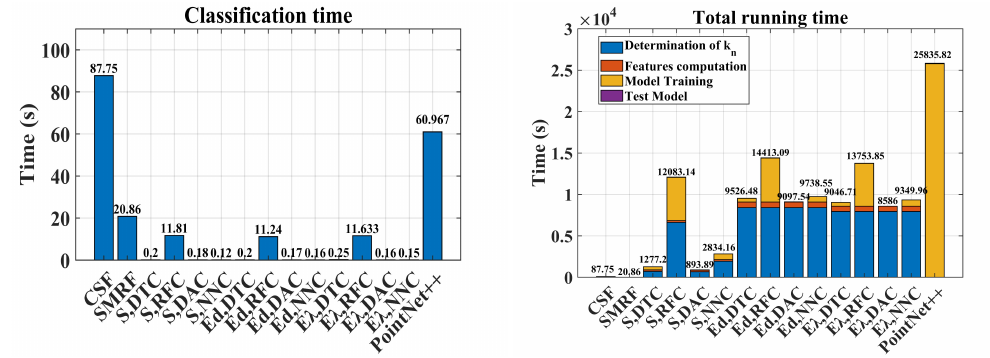
Figure 8. Left : Running time for the classification only. Right : Total running